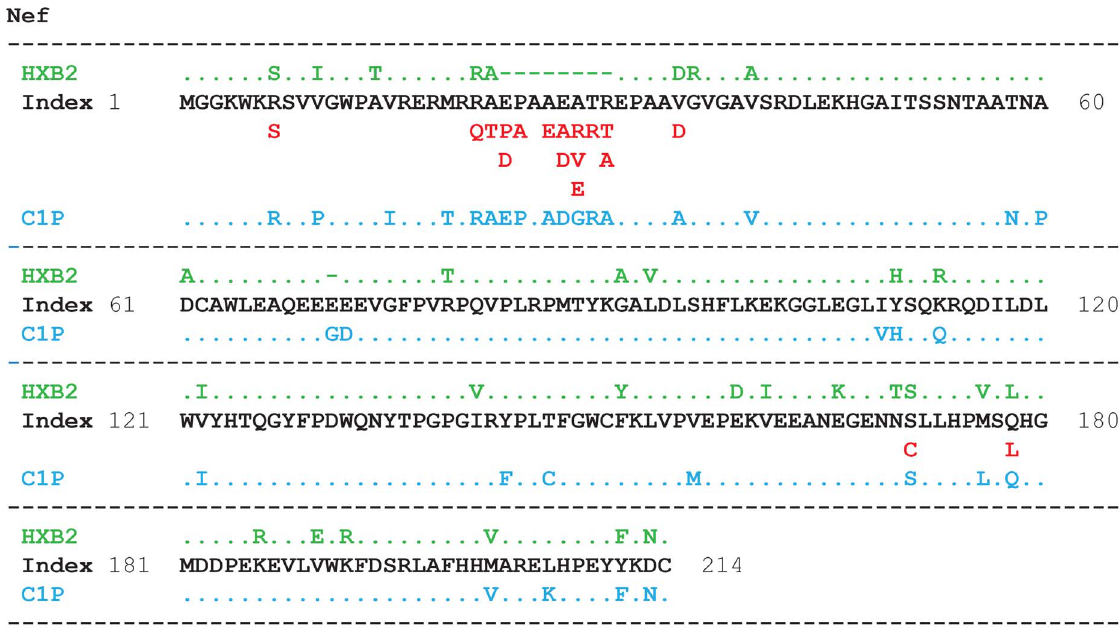
Figure 7. Comparison of HIV-1 clade B Nef concatenated index sequence with the HXB2 and C1P sequences. The numbers before and after the concatenated index sequence represent amino acid positions of the comparison; the comparison is shown in blocks of 60 amino acids. Identity of the index amino acids with those of HXB2 (green) and/or C1P (blue) is represented by ‘‘ . ’’; those that differ are shown by the respective amino acid. Amino acid mutations of the aligned viruses that did not follow the concatenation of the index are shown in red. The corresponding amino acids of HXB2 and C1P sequences are also shown at these positions, without representing identical residues by ‘‘ . ’’. The green dashes represent amino acid deletions in HXB2.